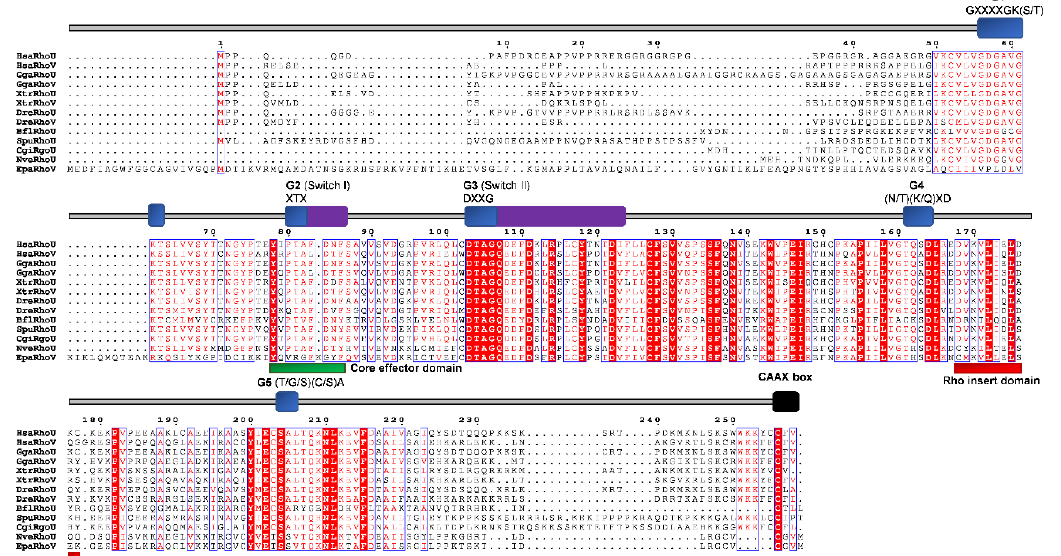
Figure 9. Sequence alignment of the RhoUV subfamily. The amino acid sequences of RhoUV GTPases were aligned using ClustalX, the secondary structures predicted using ESPript. Regions of the RhoUV proteins are indicated above the alignment; blue are the G domains, (G1, G2, G3, G4, and G5 with their respected motifs), purple are switch 1 and switch 2 domains, red is the Rho insert, green is the core effector domain, and black is the CAAX box. Blue frames are indicators of the conserved residues; white letters in red boxes represent identity, and red letters in white boxes represent similarity.